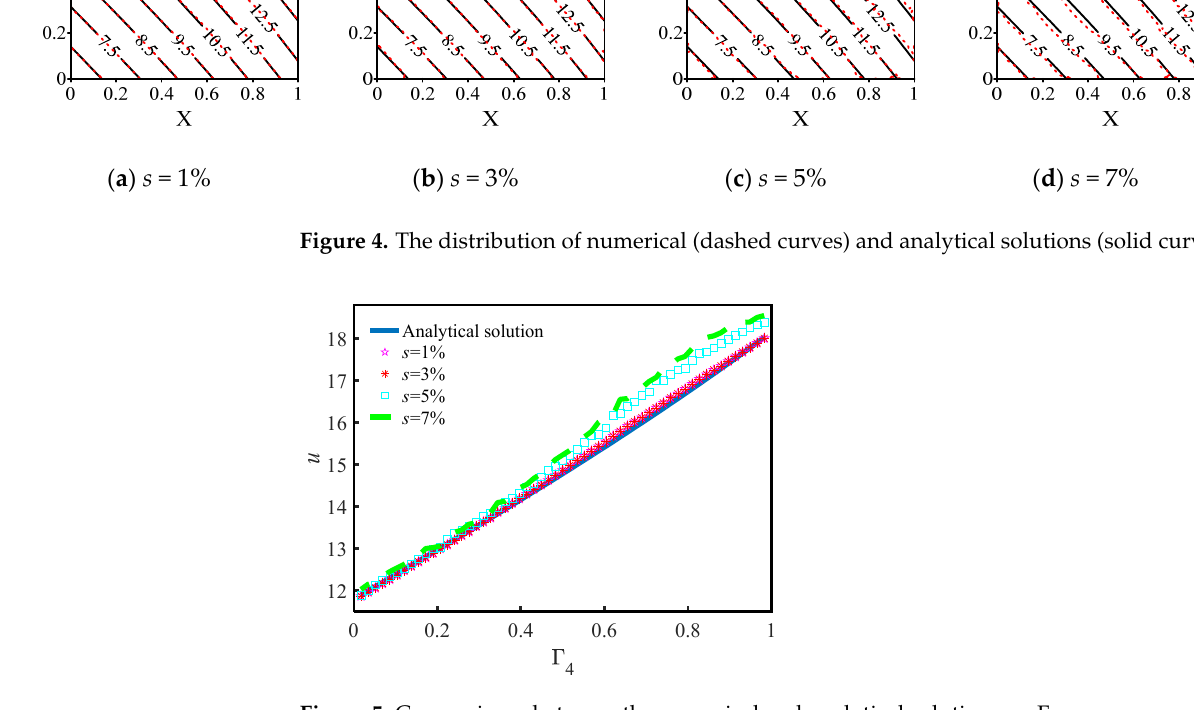
Figure 5. Comparisons between the numerical and analytical solutions on Γ 4